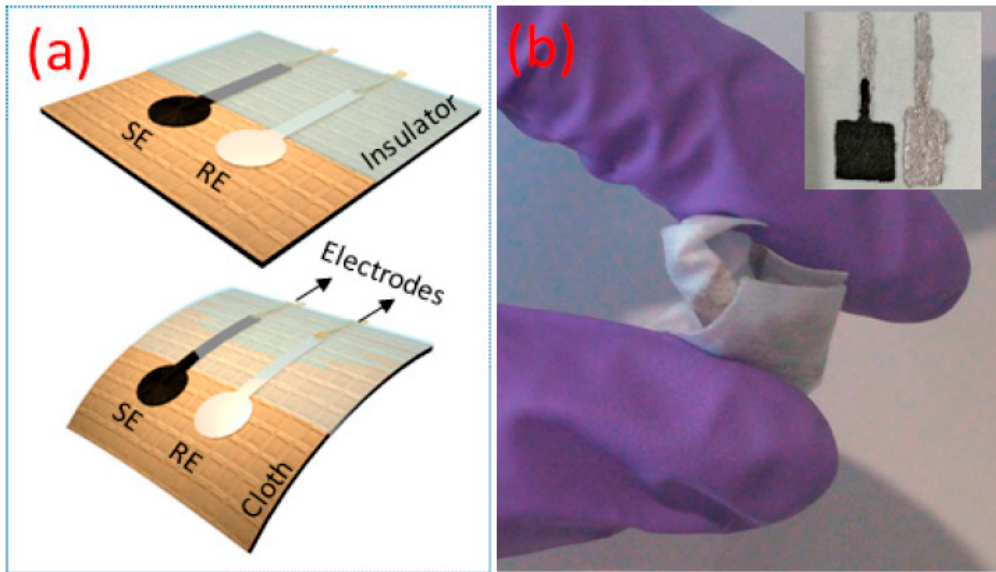
Figure 10. Schematic representation and photograph of the wearable ion selective electrodes (ISE) pH sensor. ( a ) Schematic of the pH sensor where Ag was deposited on the cloth. The sensing electrode (SE) and reference electrodes (RE) are screen printed over the Ag substrate. ( b ) Picture of the flexible cloth sensor. Inset shows the SE and RE electrodes [117]. Reprinted with permission from [117], Copyright © 2020, MDPI.